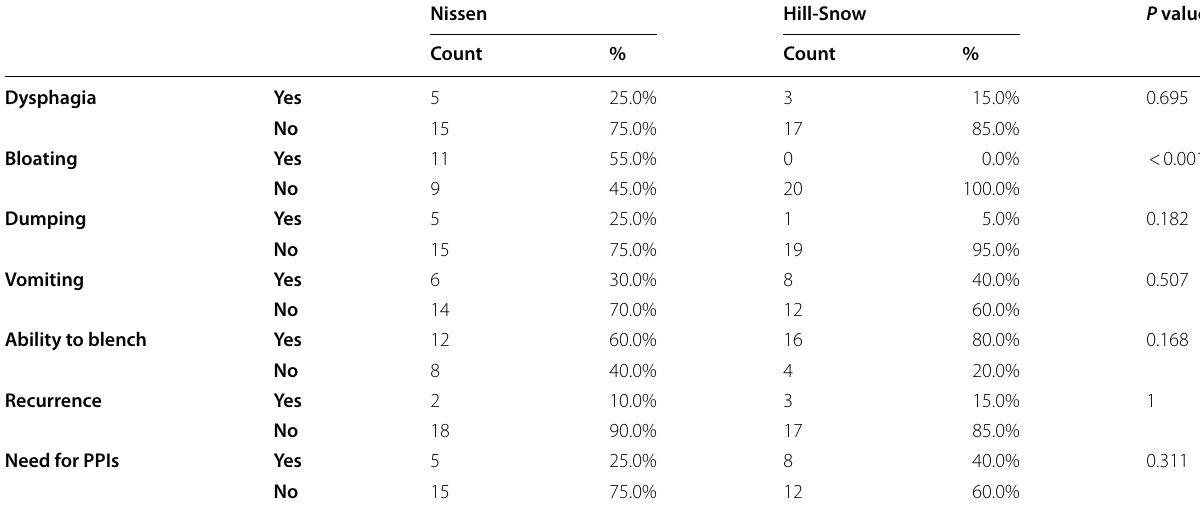
Table 4 Late postoperative assessment